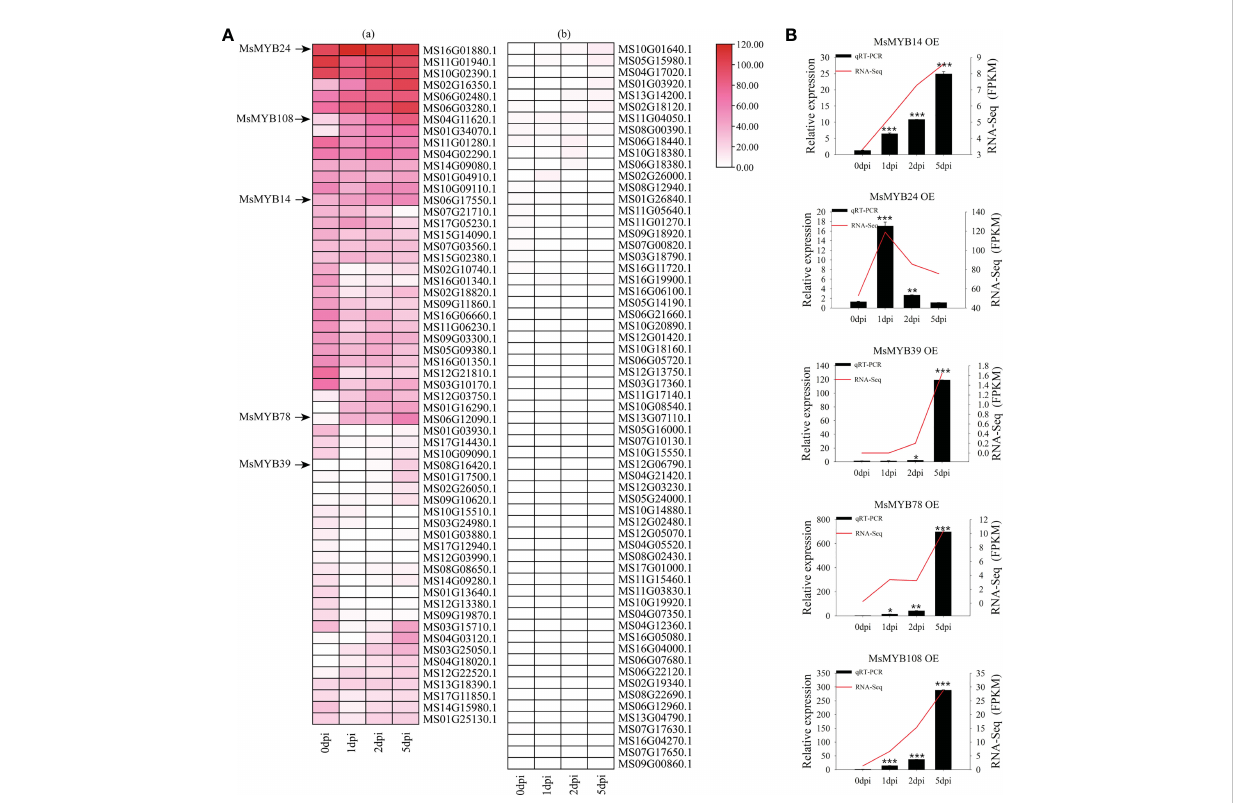
FIGURE 6 Expression pro fi les of the 128 R2R3 - MsMYB genes during response to infection by Valsa mali . (A) Heatmaps with clusters represent the expression pro fi les of R2R3 - MsMYB genes at 0, 1, 2, and 5 dpi. Color scale represents the normalized FPKM values. Red, pink, and white indicate high expression, low expression, and no expression, respectively. The cut-off of the differentially expressed R2R3 - MsMYB transcripts islog2 (fold change) ≥ 1 (Q-value < 0.05). (B) Comparison of RNA-seq data (red line) with qRT-PCR data (black column). The FPKM values from the RNA-seq are shown on the right y-axis. The relative expression levels are shown on the left y-axis. One asterisk indicates a signi fi cant difference between treatment and control plants (p ≤ 0.05). Two asterisks indicate an extremely signi fi cant difference between treatment and control plants (p ≤ 0.01). Three asterisks indicate an extremely signi fi cant difference between treatment and control plants (p ≤